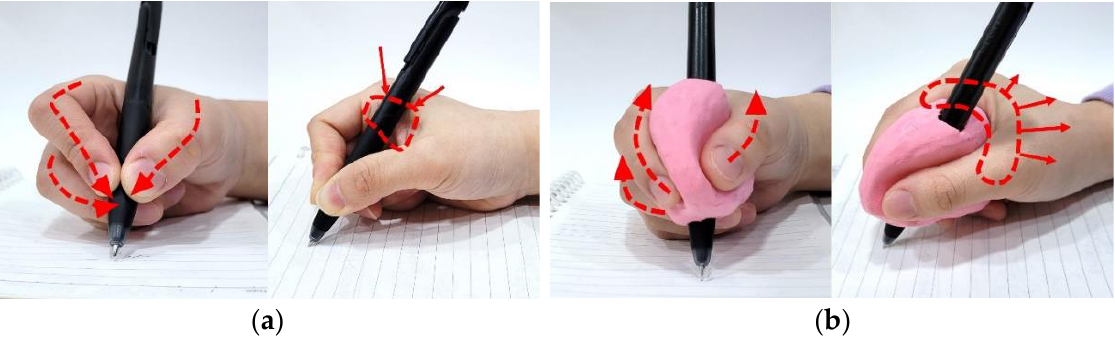
Figure 1. Ergonomic design of the WAD: ( a ) existing dynamic-tripod grip and ( b ) improved dynamic-tripod grip using a prototype NDWAD.